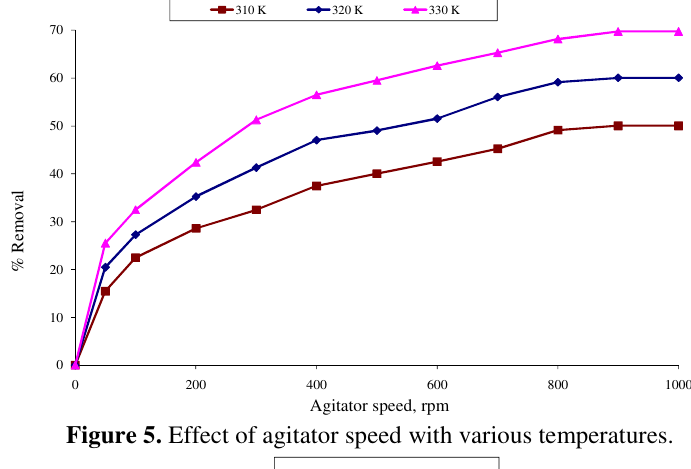
Figure 5. Effect of agitator speed with various temperatures.